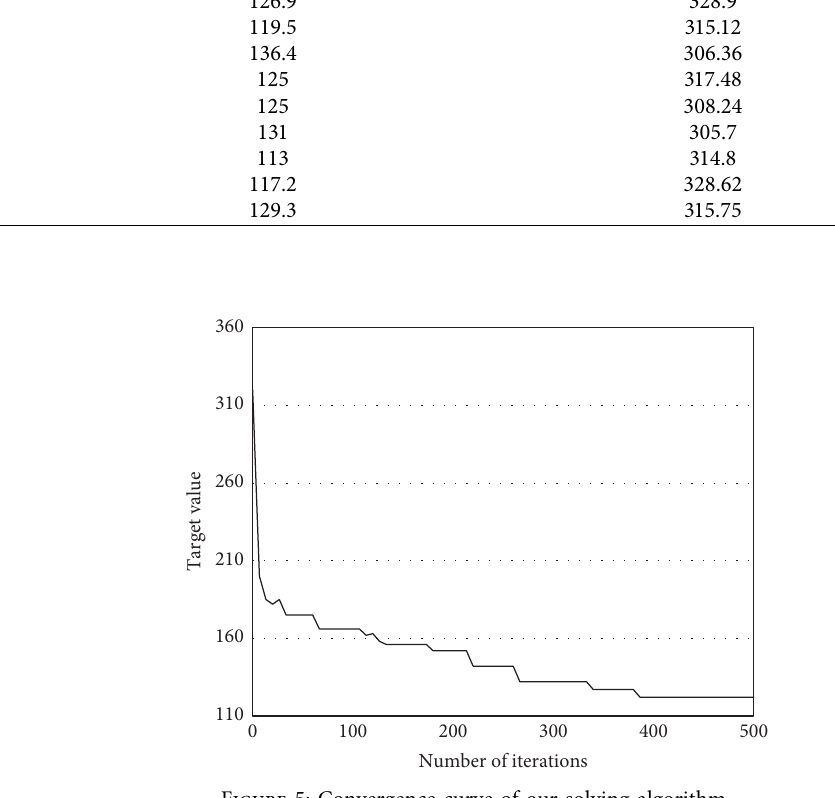
Figure 5: Convergence curve of our solving